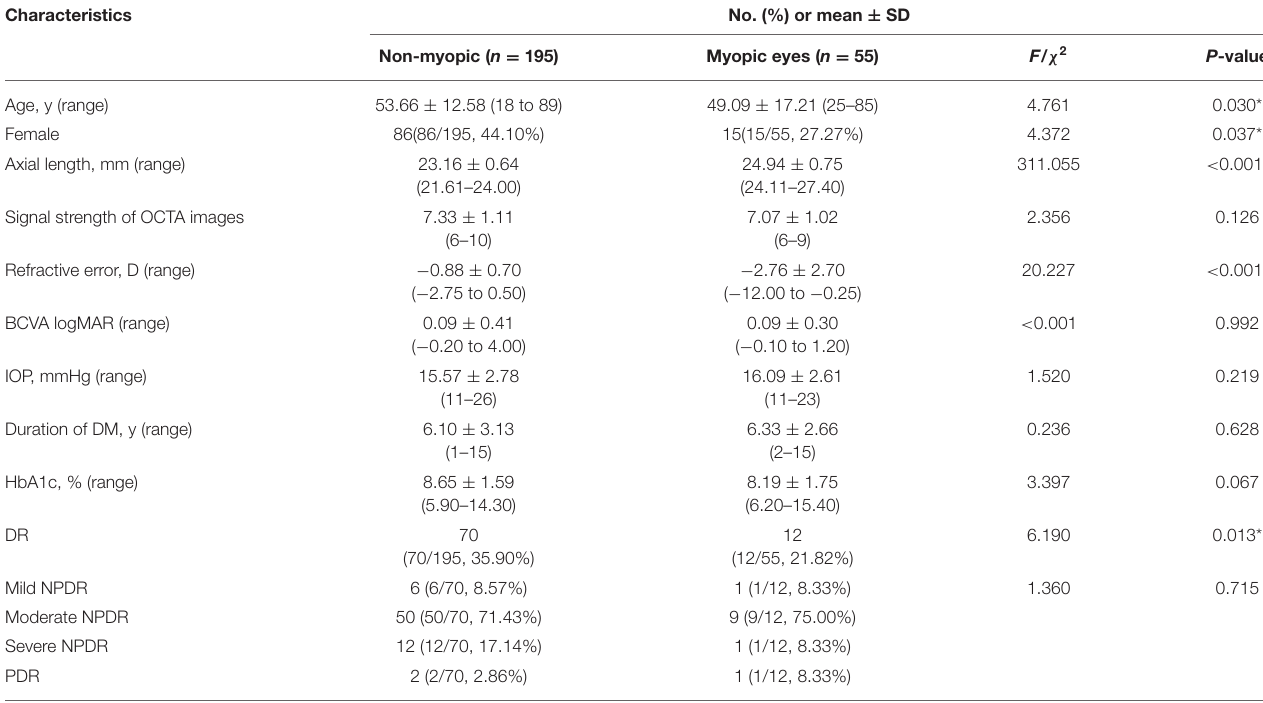
TABLE 1 | Clinical and demographic characteristics of non-myopic and myopic eyes.